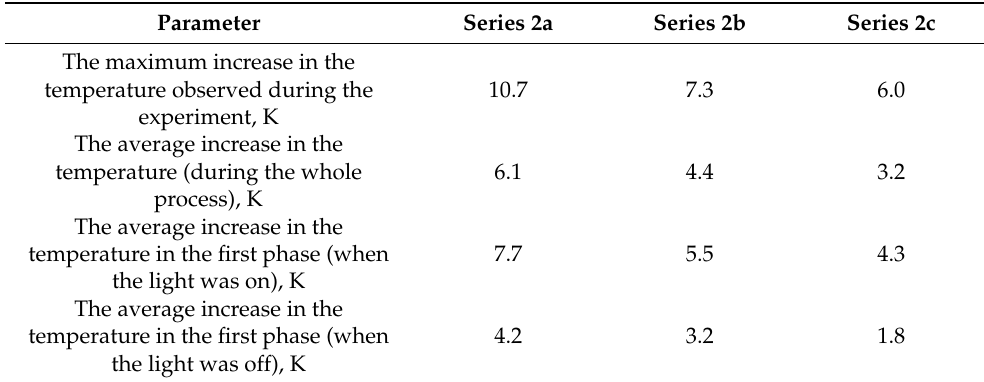
Table 7. Summarization of the increase in the temperature of the ventilation air when the SAH operated as a solar chimney and airflow was set to 100 m 3 /h (Series 2a), 150 m 3 /h (Series 2b), and 200 m 3 /h (Series 2c).